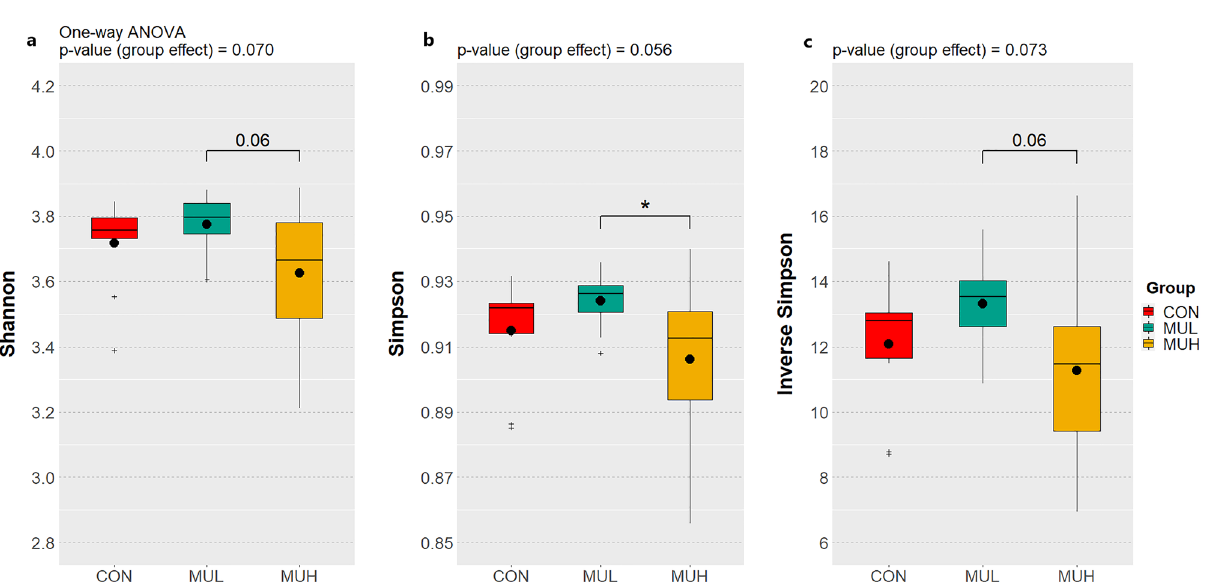
Figure 4. Shannon ( a ), Simpson ( b ), and Inverse Simpson ( c ) alpha diversity of CON, MUL, and MUH caecal contents at slaughter (42 d). Group means are drawn as black dots inside the boxes. * p -value <